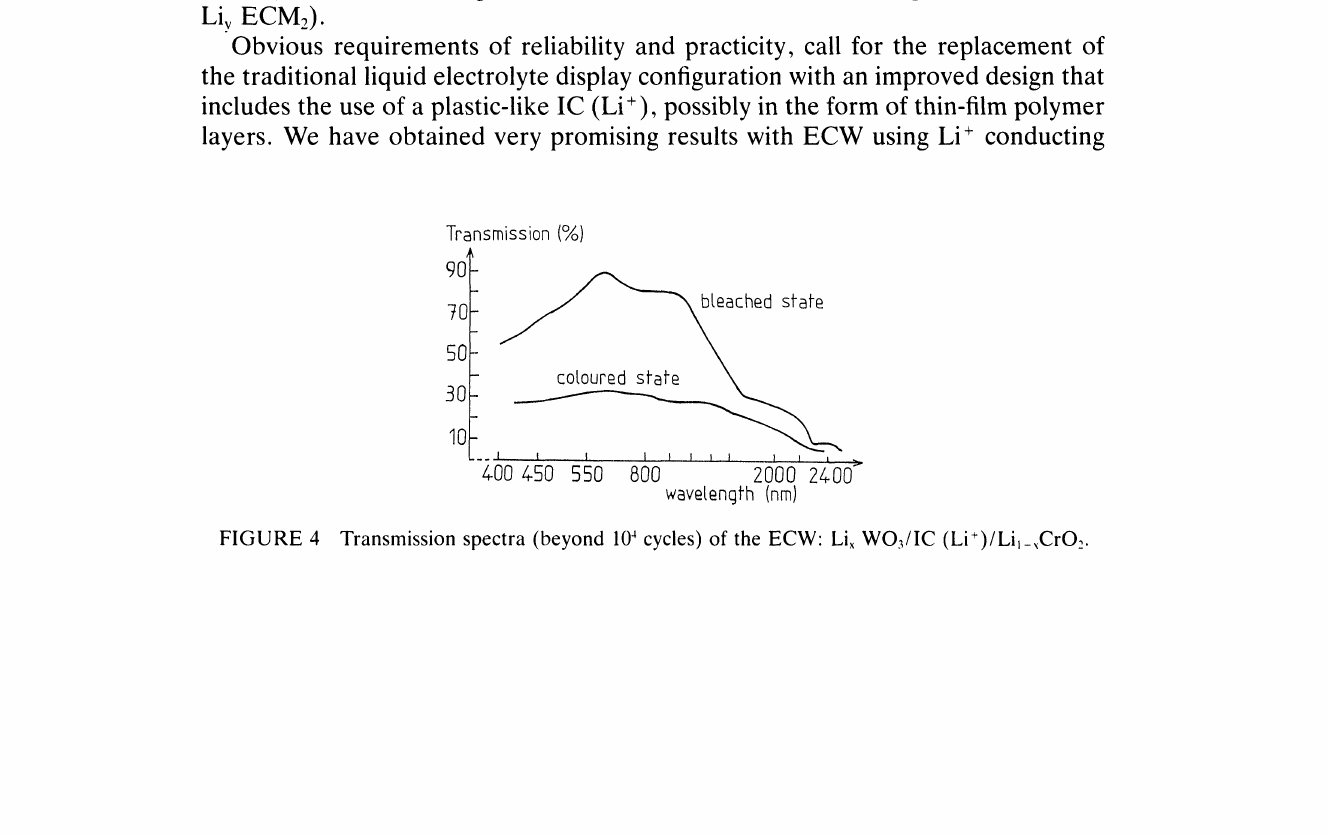
FIGURE 4 Transmission spectra (beyond 104 cycles) of the ECW: Lix WO3/IC